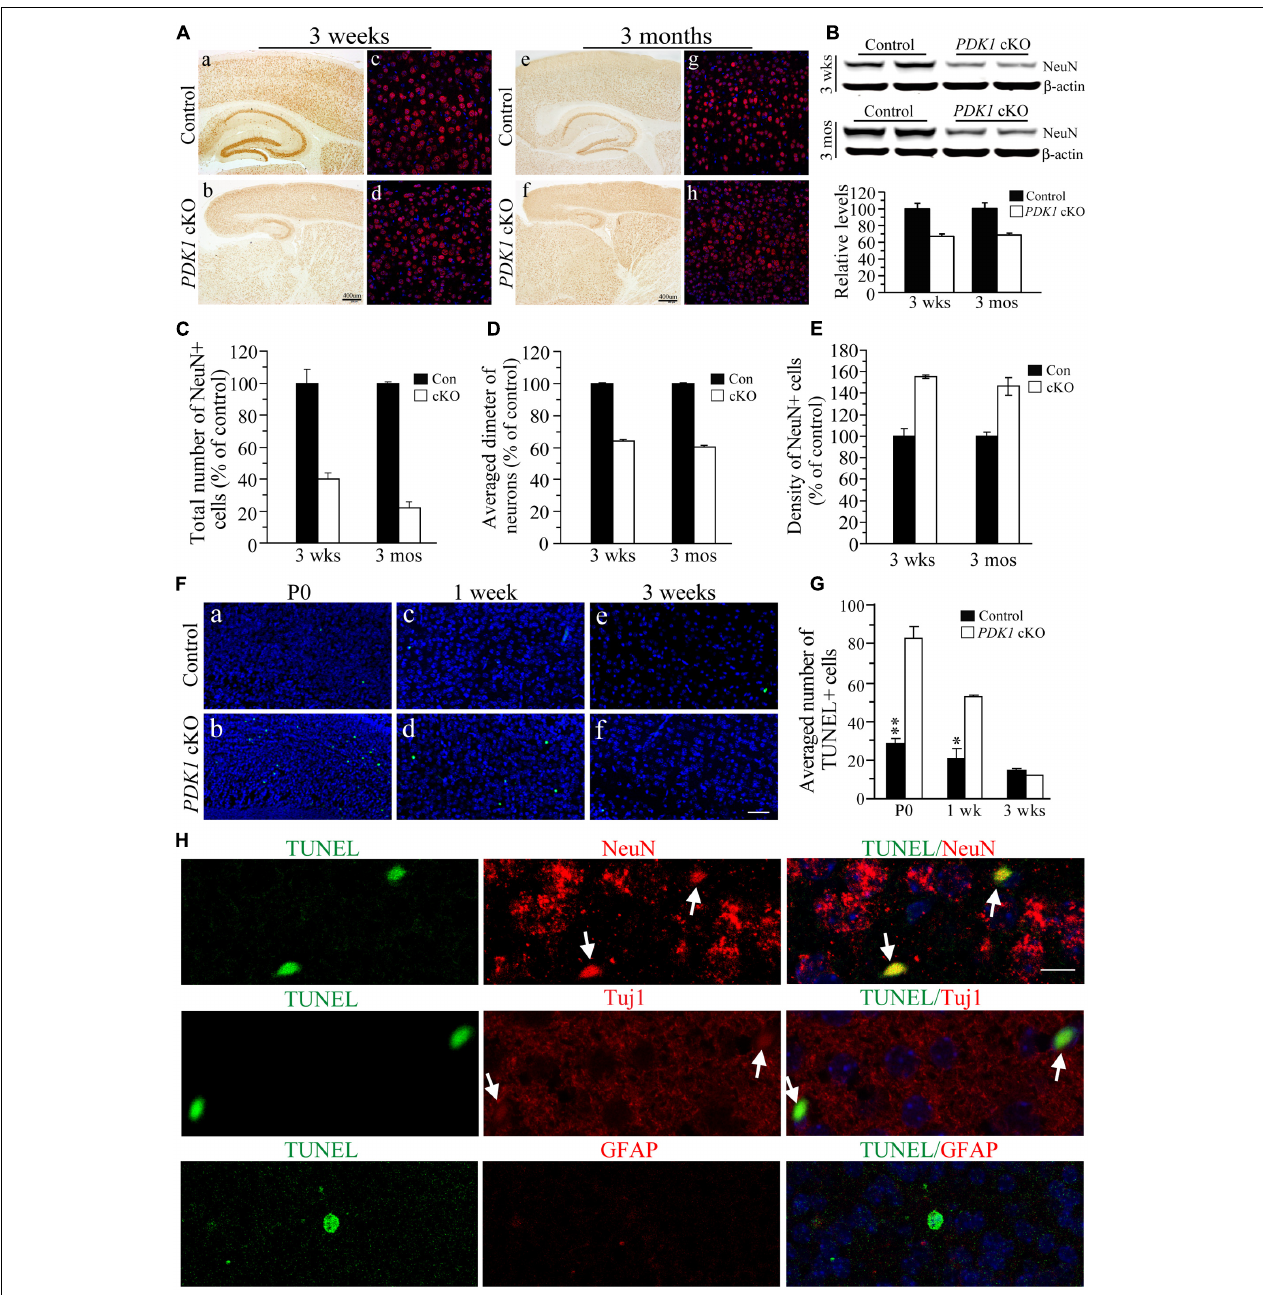
FIGURE 2 | Remarkable loss of mature neurons in PDK1 cKO mice. (A) IHC for NeuN. There were significant reductions on NeuN+ cells in the cortex and the hippocampus of PDK1 cKO mice at 3 weeks (a–d) and 3 months (e–h). Scale bar = 50 µ m. (B) Western blotting on NeuN. There were significant differences on NeuN protein levels between control and PDK1 cKO groups at 3 weeks and 3 months ( p s < 0.01). β -actin served as the loading control. (C) Relative number of NeuN+ cells was significantly different between control and PDK1 cKO mice at 3 weeks (control = 100 ± 9.8%, cKO = 39.8 ± 3.8%; n = 3–4/group; p < 0.005) or 3 months (control = 100 ± 0.8%, cKO = 22.0 ± 3.6%; n = 3–4/group; p < 0.001). (D) Relative diameter of NeuN+ cells was significantly decreased in PDK1 cKO mice at 3 weeks (control = 100 ± 0.2%, n = 118 cells from 3 mice; cKO = 60.5 ± 0.1%, n = 345 cells from 3 mice; p < 0.001) or 3 months (control = 100 ± 0.2%, n = 110 cells from 3 mice; cKO = 64.1 ± 0.2%, n = 365 cells from 3 mice; p < 0.001). (E) Cell density of NeuN+ neurons (per 1 mm 3 area) was significantly increased in PDK1 cKO mice at 3 weeks (control = 100 ± 3.9%, cKO = 146.3 ± 8.4%; n = 4 mice/group; p < 0.01) or 3 months (control = 100 ± 7.2%, cKO = 155.5 ± 1.7%, n = 4 mice/group; p < 0.001). (F) TUNEL staining in the cortex of the mice aged at P0 (a,b), 1 week (c,d), and 3 weeks (e,f). Scale bar = 50 µ m. (G) The averaged number of TUNEL+ cells per section. There were significant increases in PDK1 cKO mice at P0 and 1 week but not 3 weeks ( ∗ p < 0.05; ∗∗ p < 0.01). (H) Double-immunostaining for TUNEL/NeuN, TUNEL/Tuj1, or TUNEL/GFAP. Cells doubly positive for TUNEL(green)/NeuN(red) or TUNEL(green)/Tuj1(red) were indicated by white arrows in PDK1 cKO mice. Cells doubly positive for TUNEL(green)/GFAP(red) were not found. Scale bar = 10 µ